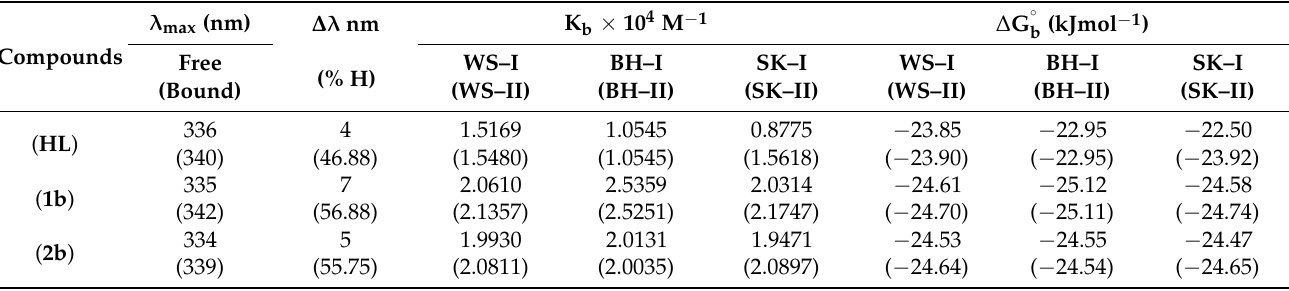
Table 1. The absorption spectral parameters of ligand ( HL ) and its complexes ( 1b – 2b ) bound to